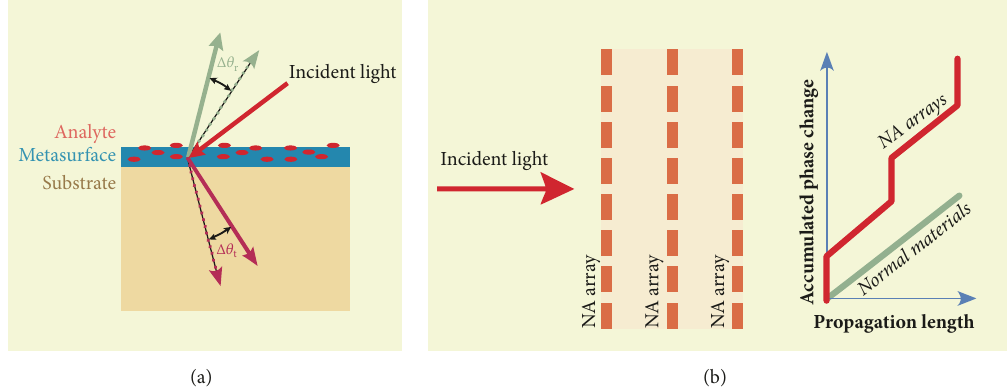
Figure 5: Applications of optical metasurface. (a) Metasurface acts as a chemical sensor: the molecules are attached to the metasurface, resulting in the transfer of resonances of the nanoantennas components. This leads to anomalous reflection and transmission beam angle changes (indicated by (cid:2) 𝜃 𝛾 and (cid:2) 𝜃 𝑡 , respectively). (b) Schematic diagram of a superrefractive index medium consisted of 3 metasurfaces (left panel). The right panel displays the cumulative phase transition of light passing through a common homogeneous material (green line) and through a medium consisting of 3 metasurfaces (red polyline), the slope of every red polyline representing the effective refractive